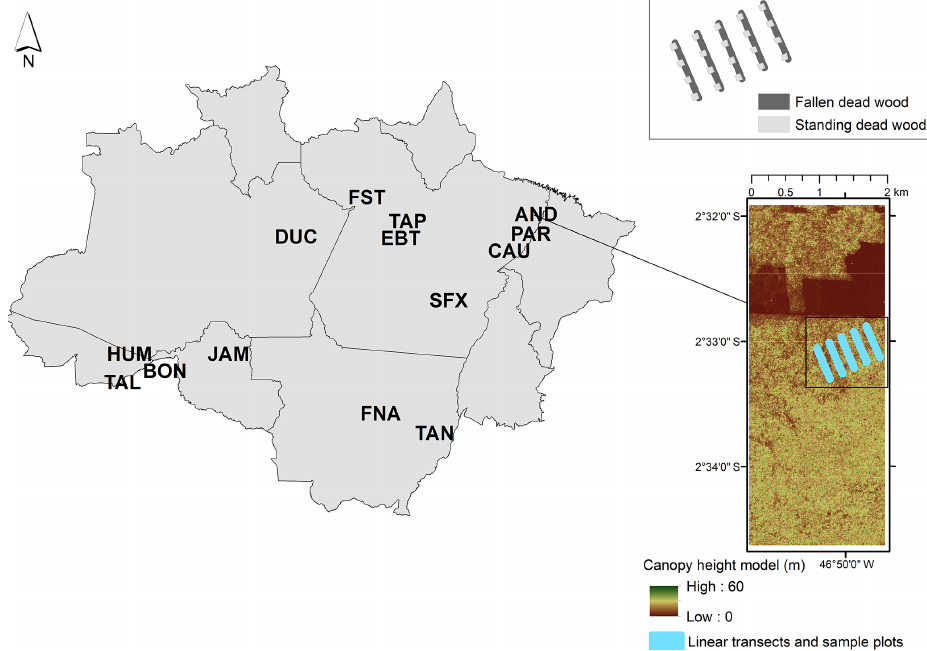
Figure 1. Location of the study sites in the states of Brazilian Legal Amazon. Site codes are shown at approximate locations (see Table 1). The lower inset shows the canopy height model (m) from the AND site as an example of the lidar data covering the field transects for sampling standing and fallen CDW. The upper inset shows the sample design used with line intercept samples to quantify fallen CDW and associated square forest inventory plots for aboveground live and standing CDW. CAU, FST, JAM, TAL, TAN, DUC, and TAP sites were classified as intact; CAU, FST, and JAM sites were classified as reduced-impact logging; BON, PAR, and BET sites were classified as conventional logging; AND, HUM, BET, SFX, TAL, and TAN sites were classified as burned; AND, BON, FNA, and PAR sites were classified as logged and burned; PAR, BET, and SFX sites were classified as secondary; BON, CAU, HUM, SFX, and TAN sites had unclassified